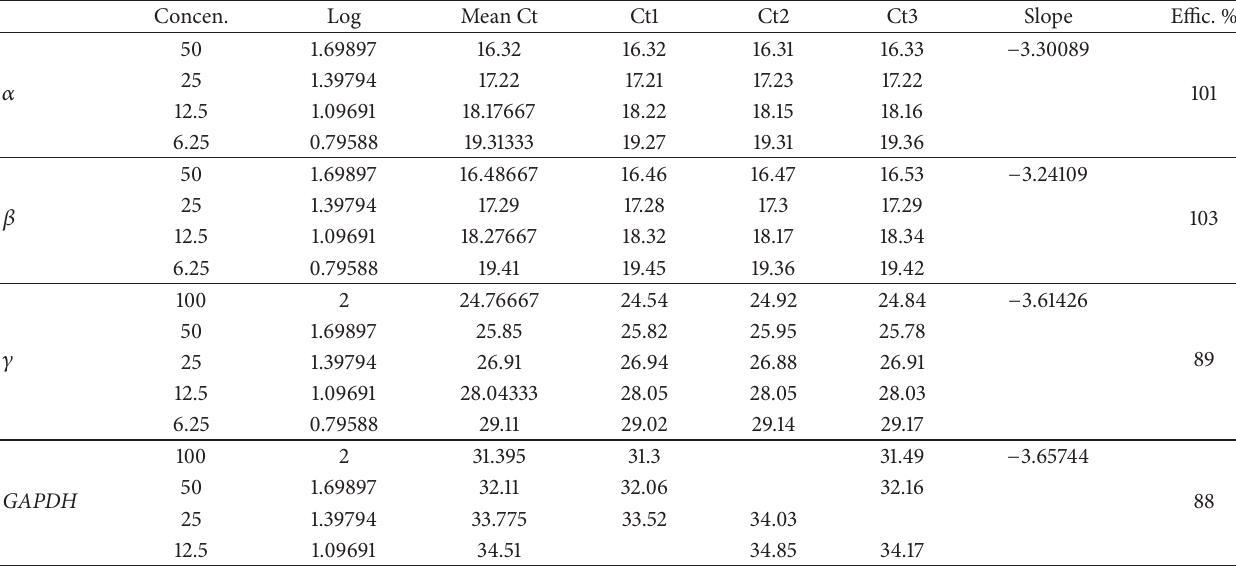
Table 2: Determination of the real-time PCR efficiencies.